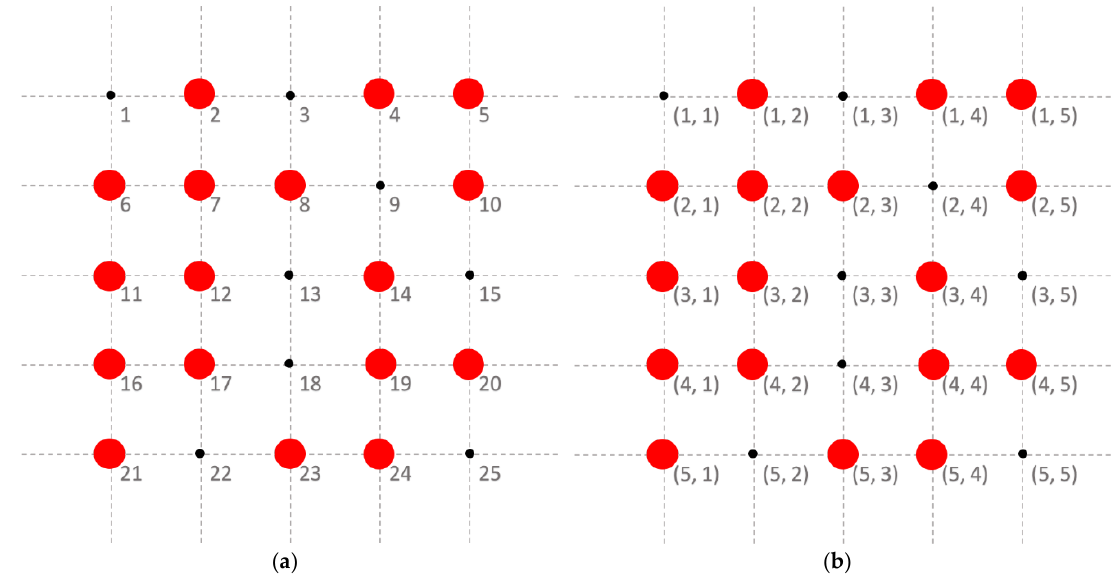
Figure 1. An example of vector and coordinate expressions of sensor locations. (Note: sensor data are observable at the locations with red dots, and missing at the remaining locations.). ( a ) 𝑖 ; ( b ) s 𝑖 = (𝑝, 𝑞) . Two assumptions are made prior to the introduction of the proposed For the target process, we assume that 𝛍 = 𝛍 0 for all sensor locations 𝐬 𝑖 with 𝑖 = 1, … , 𝑛 , when no out-of-control clusters occur while 𝛍 = 𝛍 1 when an out-of-control cluster occurs. Therefore, we